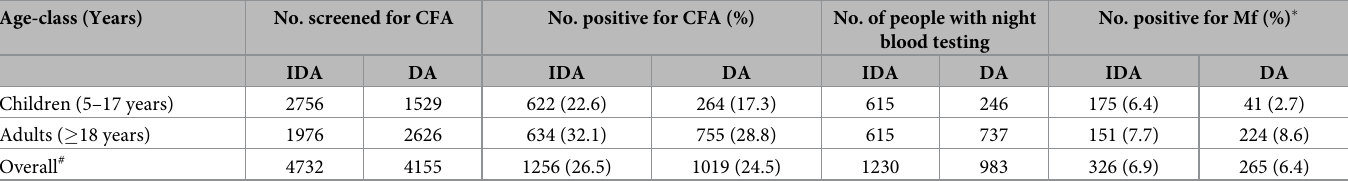
Table 3. Age-specific prevalence of CFA and Mf by MDA treatment areas. Age-class (Years) No. screened for CFA